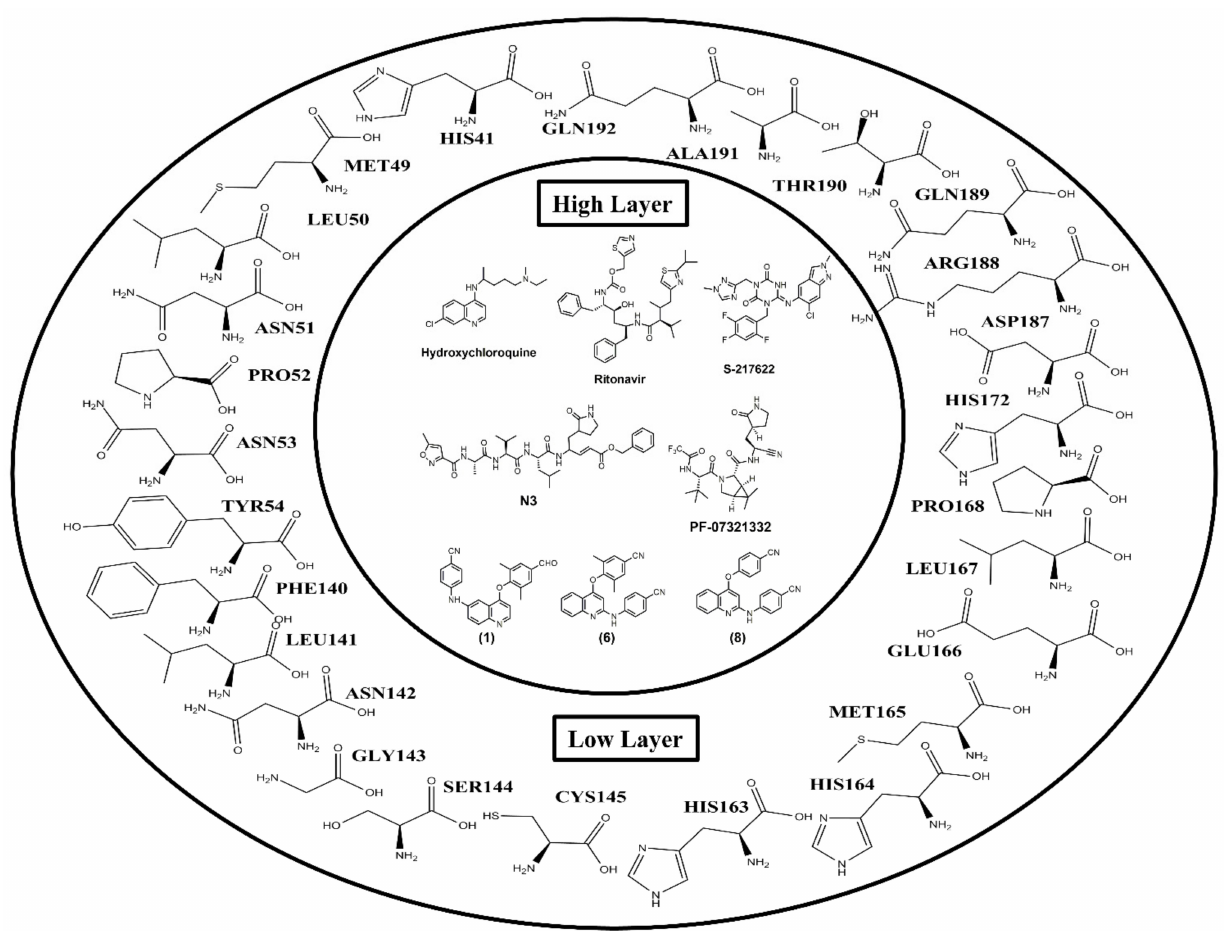
Figure 4. Adopted model system of ligands bound to the binding site of M pro